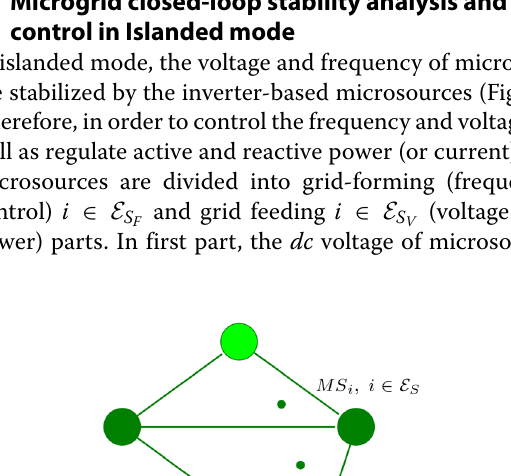
control in Islanded mode In islanded mode, the voltage and frequency of microgrid are stabilized by the inverter-based microsources (Fig. 8).